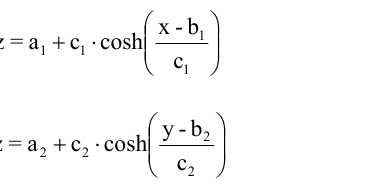
Figure 4. Simulated catenary curves (x-y-z)